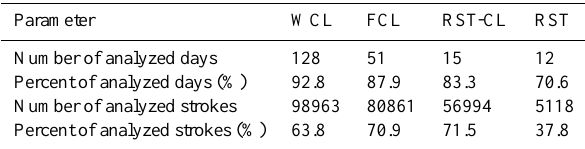
Table 2. Number and percentage of days and strokes used in the analysis. The percentages are calculated based on the difference in the data volume after neglecting strokes with absolute peak currents < = 10kA, strokes located in radius > = 250km from the center of the study region and days when the remaining number of strokes in this radius < = 20day − 1